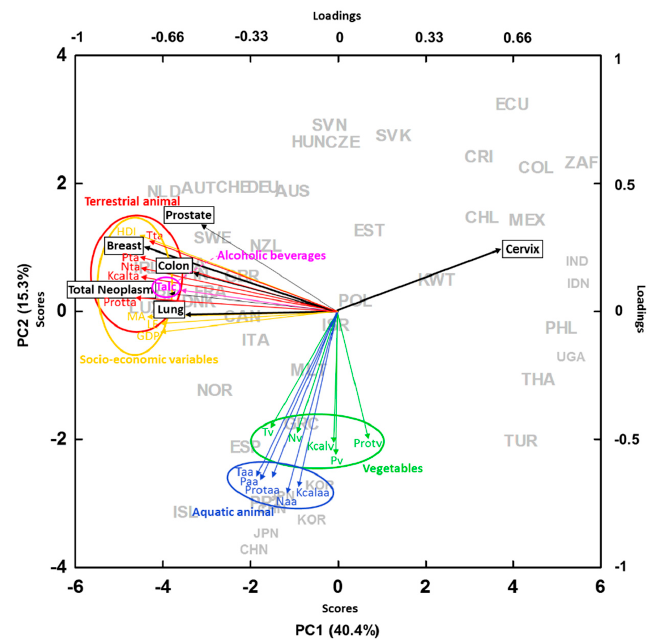
Figure 5. PCA (principal component analysis) with per capita country neoplasm prevalence (L = lung, C = colon, Ce = cervix, P = prostate, TN = total neoplasm, B = breast), different socioeconomic variables (LE = life expectance at birth, AM = age mean, HDI = human development index, GDP = gross domestic product per capita) and food sources (t = total, N = nitrogen intake, P = phosphorus intake, prot = protein and Kcal = kilocalories per capita intake) from terrestrial animal sources (ta) (red), vegetables (v) (green), and aquatic animal (aa) (blue) in the period 1990–2010. AUS = Australia, AUT = Austria, BEL = Belgic, CAN = Canada, CHE = Switzerland, CHL = Chile, CHN = China, COL = Colombia, CRI = Costa Rica, CZE = Czech Republic, DEU = Germany, DNK = Denmark, ECU = Ecuador, ESP = Spain, EST = Estonia, FIN = Finland, FRA = France, GBR = United Kingdom, GRC = Greece, HUN = Hungary, IDN = India, IND = Indonesia, IRL = Ireland, ISL = Iceland, ISR = Israel, ITA = Italy, JPN = Japan, KOR = Korea, KWT = Kuwait, LUX = Luxembourg, MEX = Mexico, MLT = Malta, NLD = Netherlands, NOR = Norway, NZL = New Zealand, PHL = Philippines, POL = Poland, PRT = Portugal, SVK = Slovakia, SVN = Slovenia, SWE = Sweden, THA = Thailand, TUR = Turkey, UGA = Uganda, USA = United States of America, ZAF = South